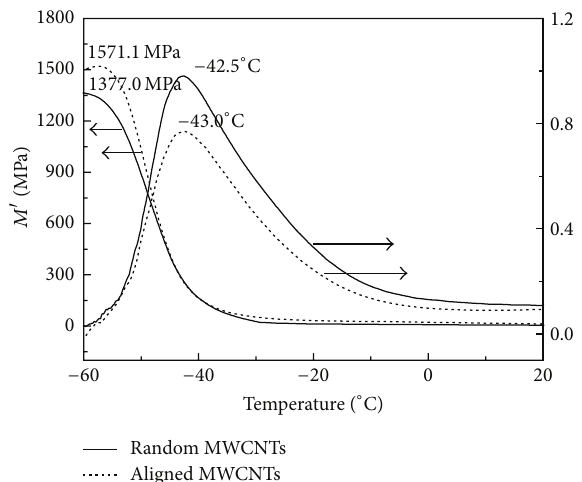
Figure 7: Dynamic mechanical behavior of composite with 10vol. % of MWCNTs oriented by a flow field and not. Storage modulus 𝑀 󸀠 and loss factor tan 𝛿 are included.